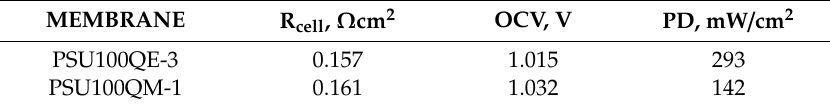
Table 4. Electrochemical parameters of the tested MEAs. OCV: open circuit